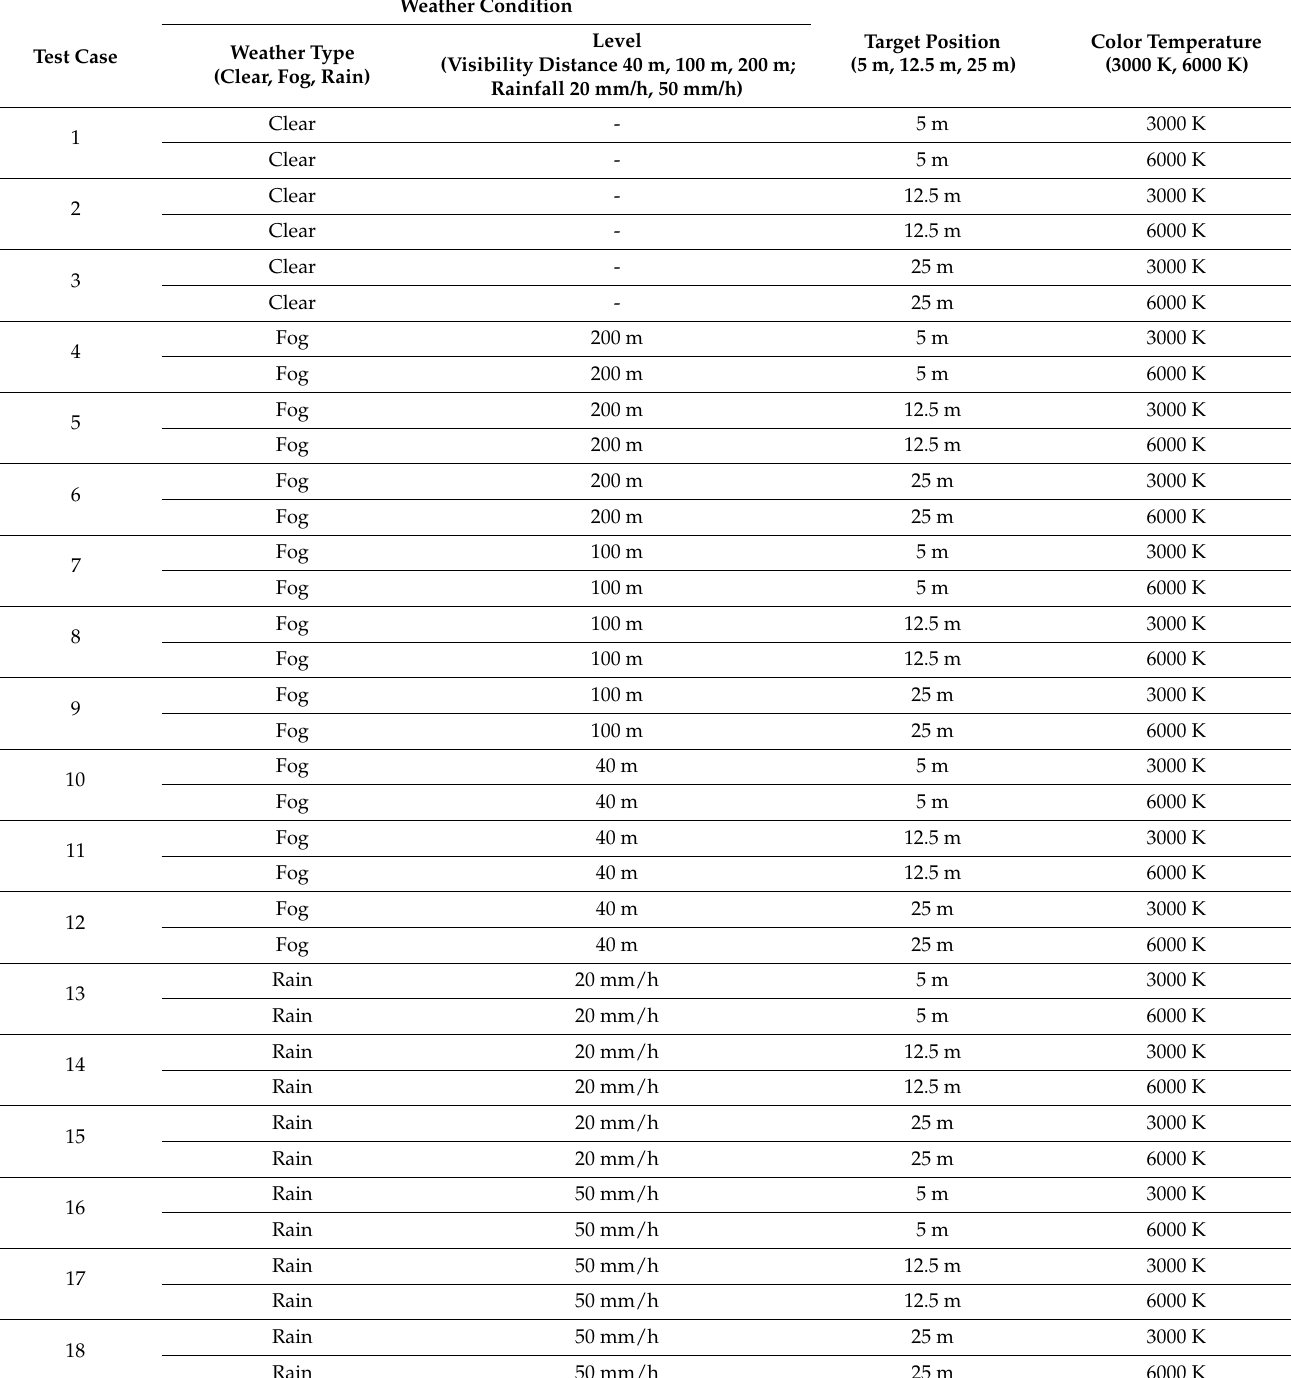
Table 3. Test cases considering weather